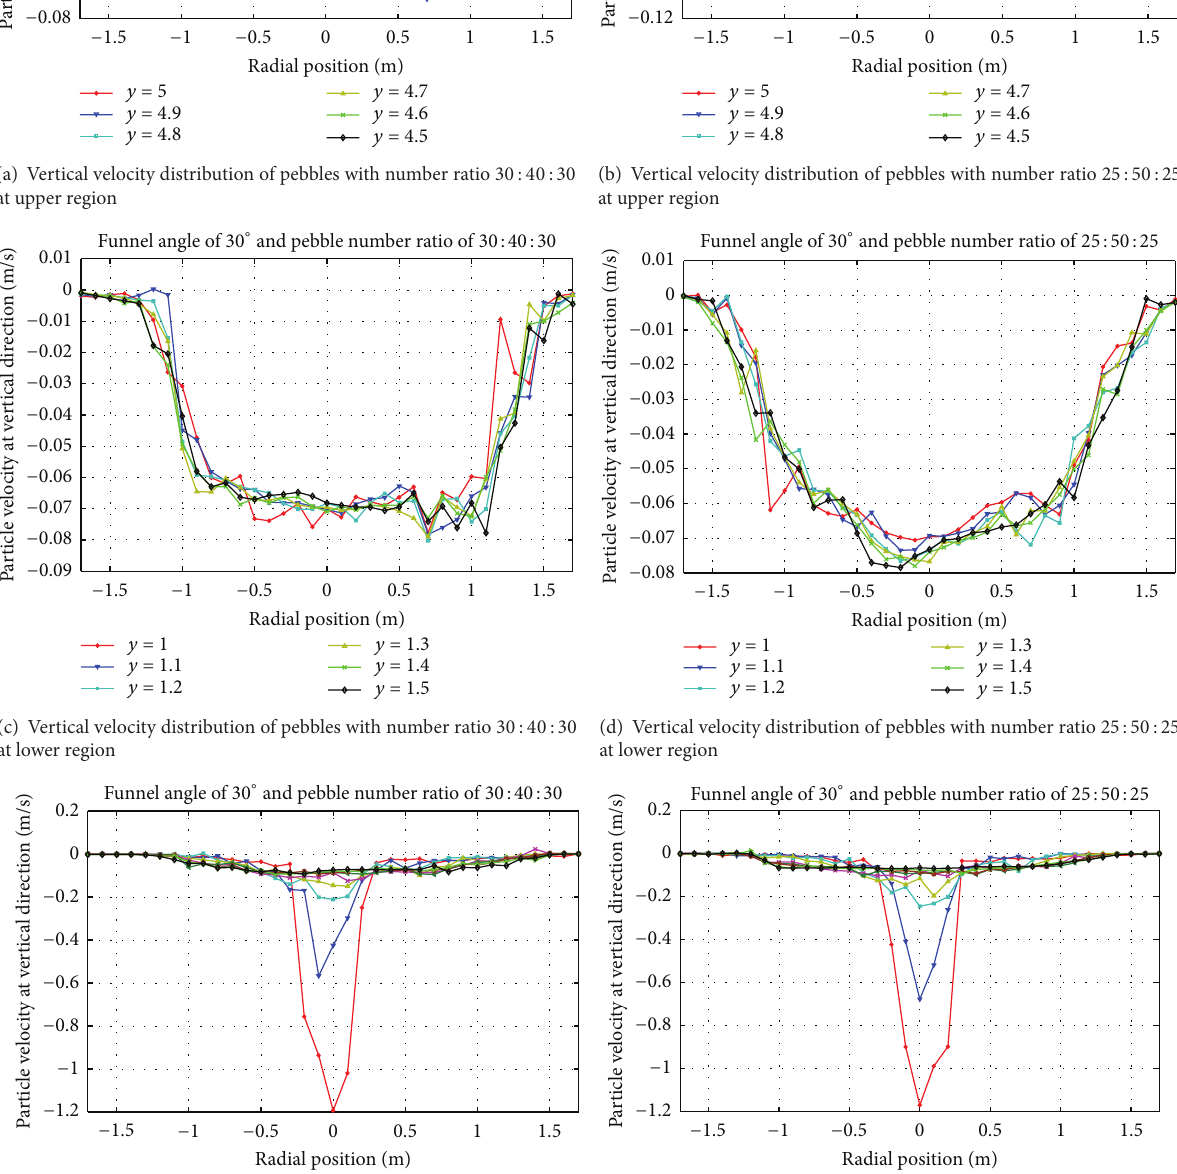
(e) Vertical velocity distribution of pebbles with number ratio 30:40: (f) Vertical velocity distribution of pebbles with number ratio 30 at cone region 25:50:25 at cone region Figure 6: Vertical velocity distributions of pebbles at different number